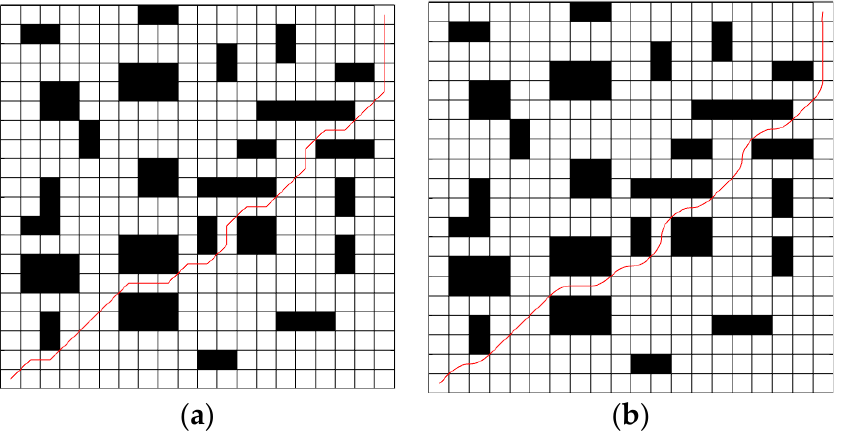
Figure 9. Path-smoothing experiments. ( a ) traditional algorithms, ( b ) smooth processing path.